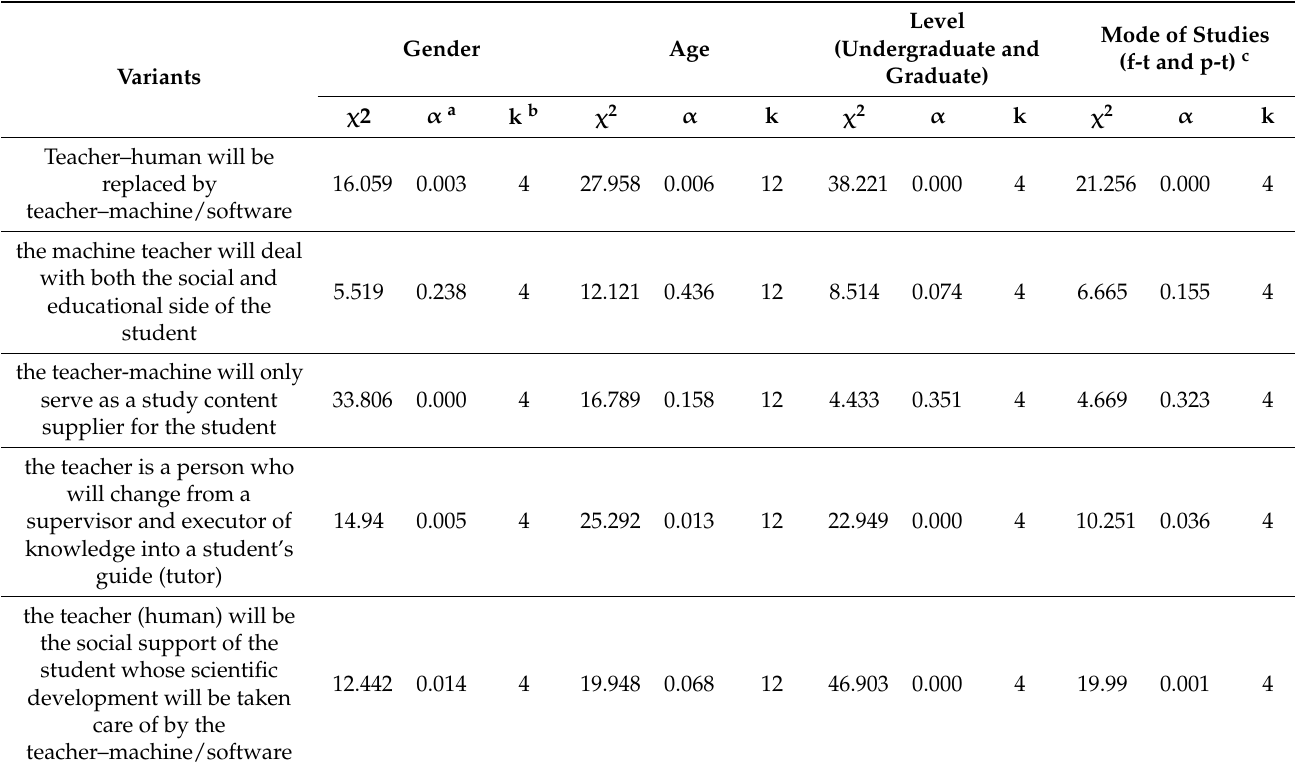
Table 4. The position of the teacher in the future (in 30 years) in the Smart learning trend in terms of gender, age, level, and mode of study–test of independence χ 2